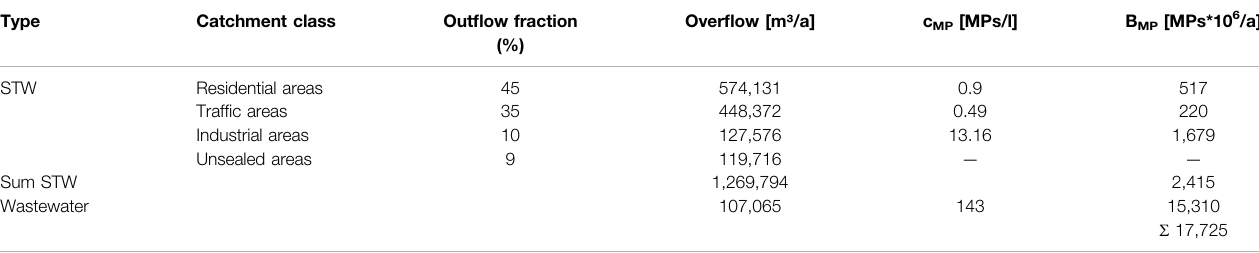
TABLE 2 | Microplastic (MP) emission (B MP ) due to combined sewer over fl ows separated according to the proportion of waste- and rainwater. The out fl ow fraction corresponds tothepercentage shareoftherainfallrunoff ( Q R for storm- (STW) and wastewater were obtained from the literature ( Supplementary Information SI1